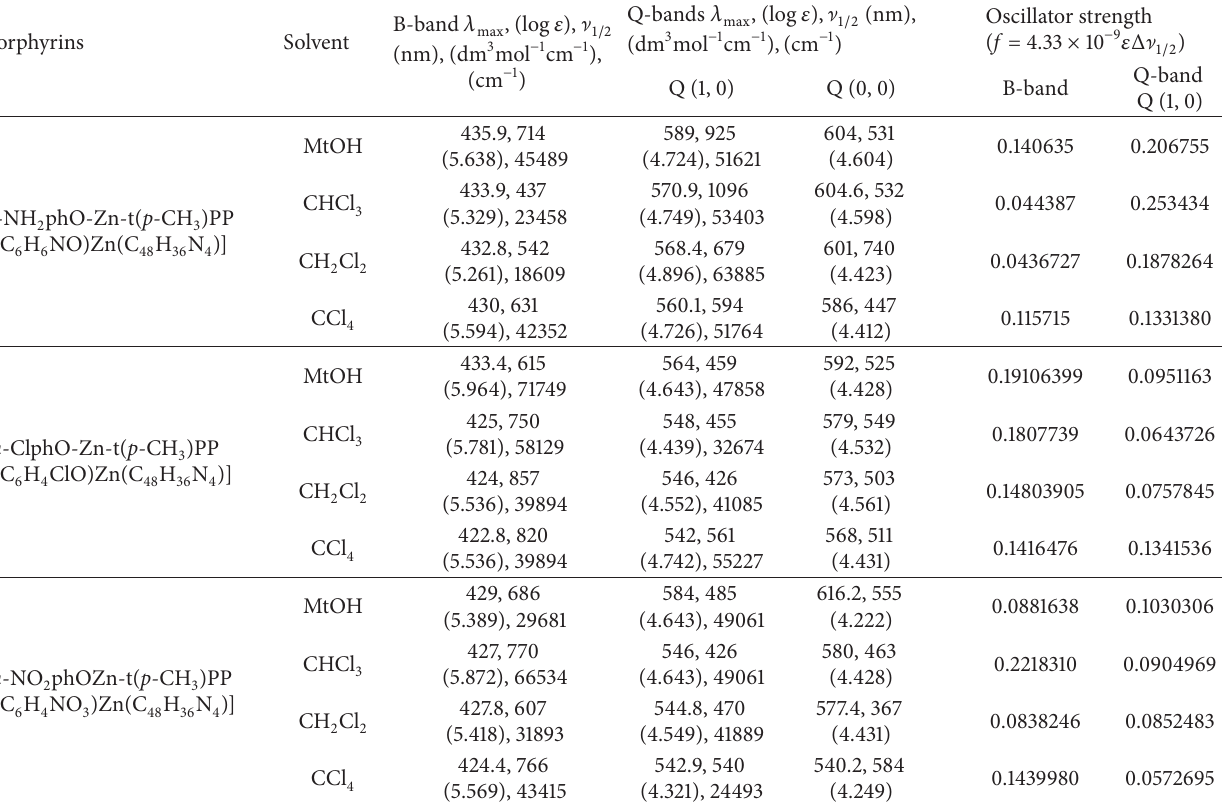
Table 3: Optical absorption data of X-Zn-t( p -CH “ f ”